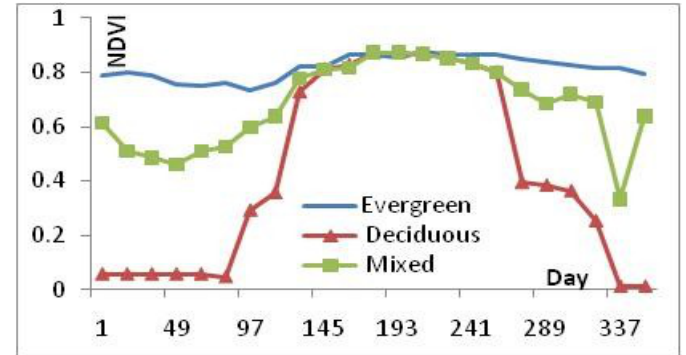
Figure 2. Forestland NDVI histogram curve and mode